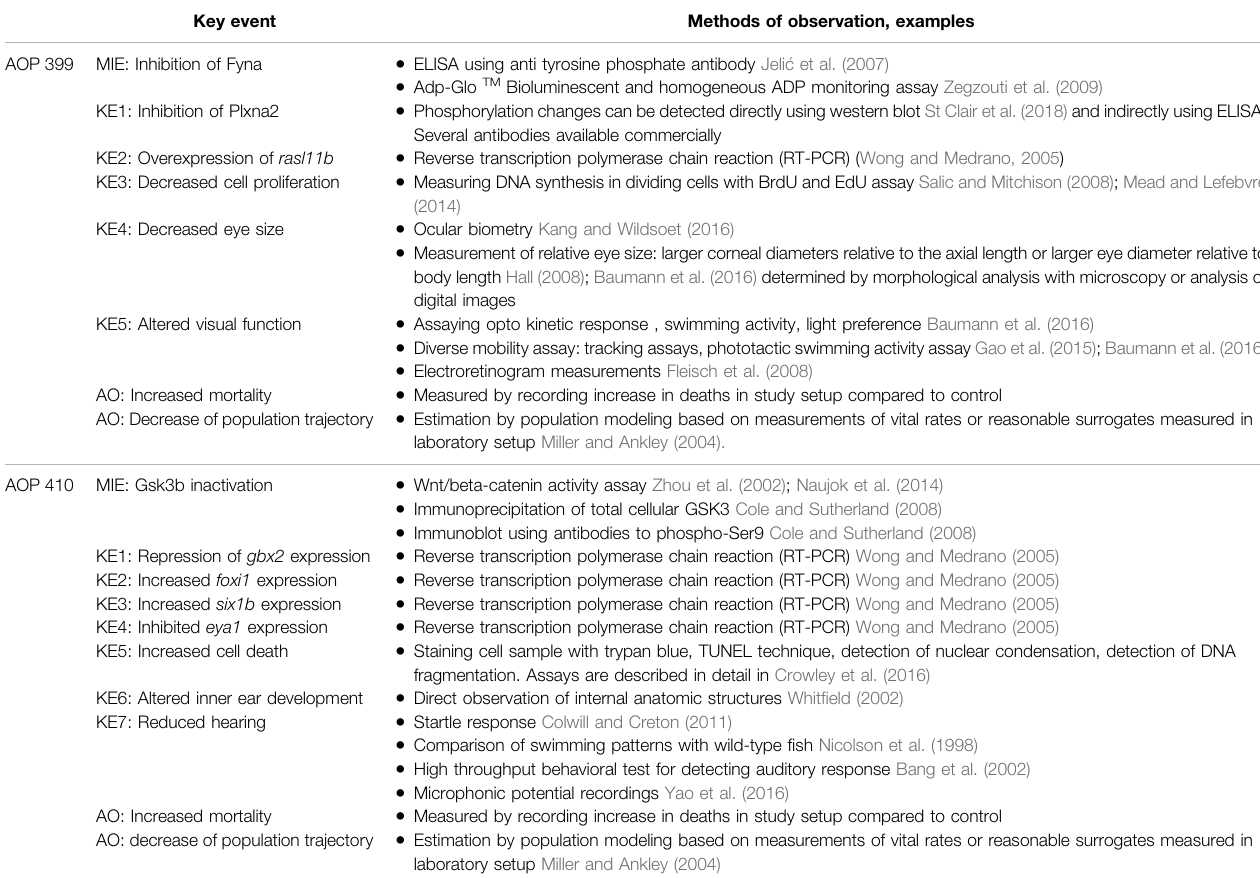
TABLE 5 | Measurement methods available for the KEs in AOPs 399 and 410. Key